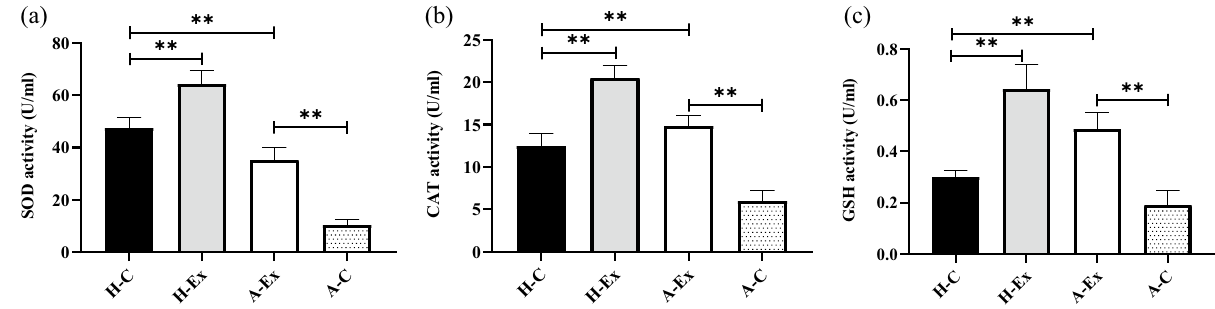
Figure 7. Resistance training ameliorates oxidative stress in gastrocnemius muscle in an animal model of Alzheimer’s disease. ELISA quantitative analysis of ( a ) Superoxide dismutase (SOD), ( b ) Catalase (CAT),